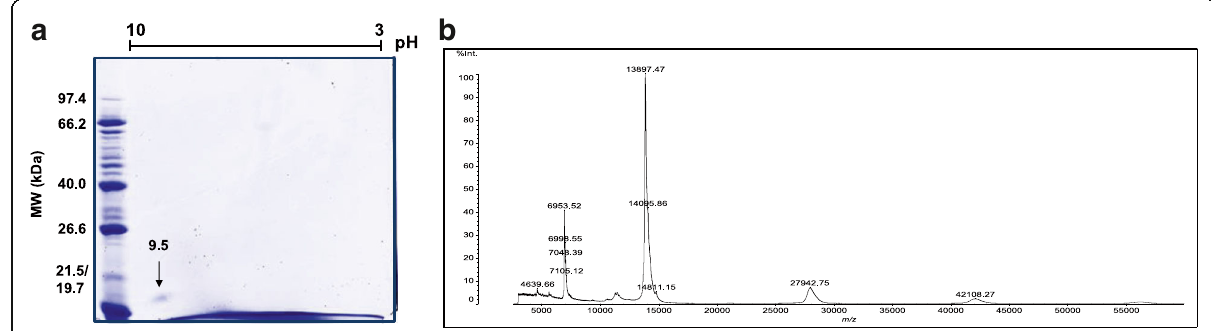
Fig. 2 Two-dimensional electrophoresis and mass spectrum of PocTX. a PocTX (15 μ g) was analyzed by 2D SDS-PAGE electrophoresis using a 7-cm strip, with non-linear pH values from 3 to 10. After isoelectric focusing, the strip was applied to a 15% polyacrylamide gel. The gel was stained with Coomassie Blue G250. b Then, PocTX was analyzed by mass spectrometry (MALDI-TOF) to determine its m/z ratio, using sinapinic acid as the ionization matrix, in the mass range of 5000-60,000